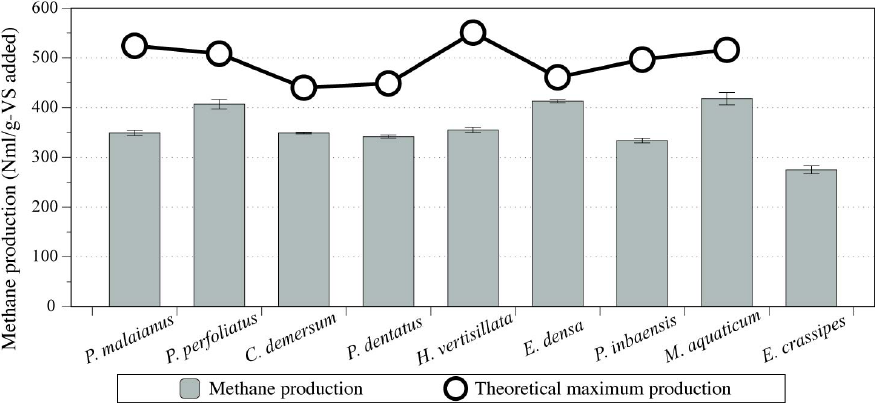
Figure 1. Cumulative methane production of different aquatic plant